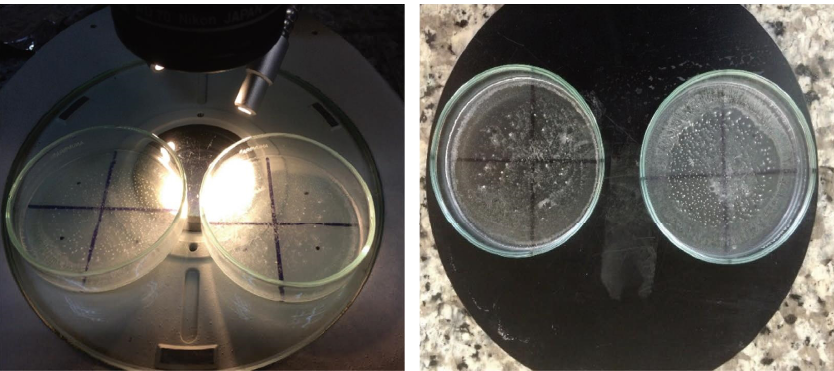
Figure 6: Counting microplastic particles by dividing the plate surface. Table 3: Results of counting particles by appearance and type in spring.